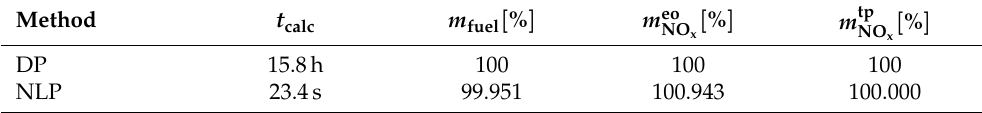
Figure 3. Comparison of the solution to the nonlinear program (NLP) to the dynamic programming (DP) benchmark for the nonroad transient cycle (NRTC) with ϑ ( 0 ) = 100 ◦ C. Shown are the emitted engine-out NO x mass m eo , the ATS temperature ϑ , the NO x -reduction efficiency η DeNOx , and the NO x emitted tailpipe NO x mass m tp . All values were normalized. NO x Table 3. Comparison of the DP and NLP optimizations for the NRTC with ϑ ( 0 ) = 100 ◦ C. The consumed fuel mass is denoted m fuel and the required computation time is denoted t calc . The results of the DP optimization were used for the